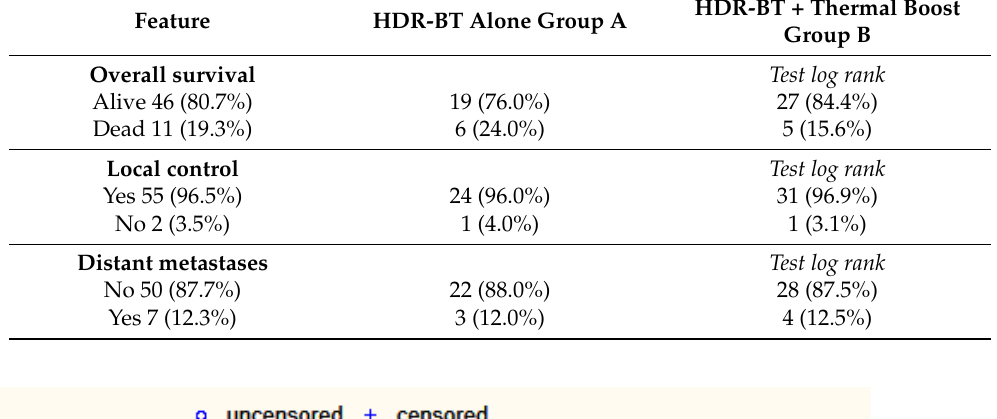
Table 2. Long-term clinical result.